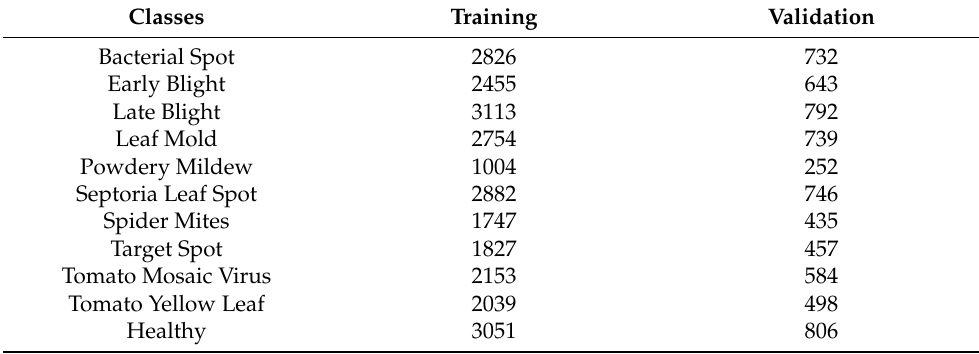
Table 2. Distribution of images among the classes in the first